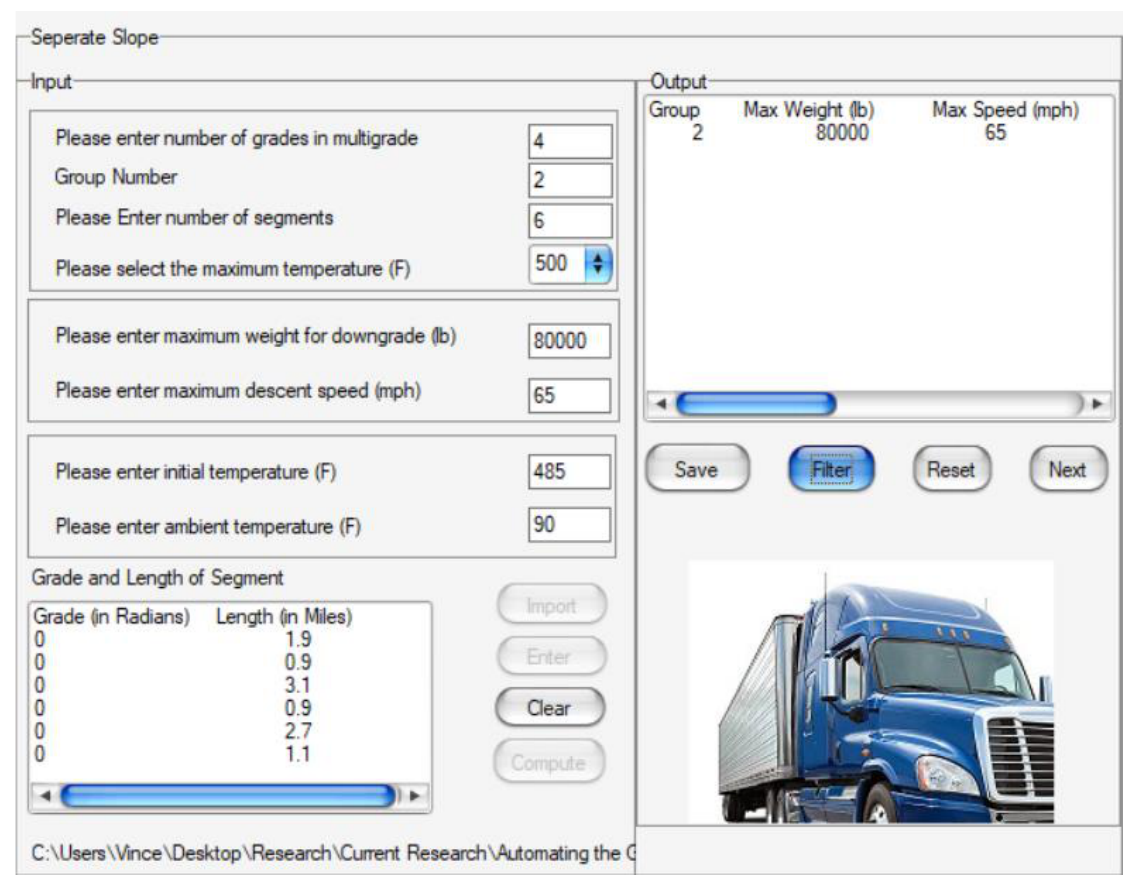
Figure 7: Separate downgrade analysis option: non-braking phase